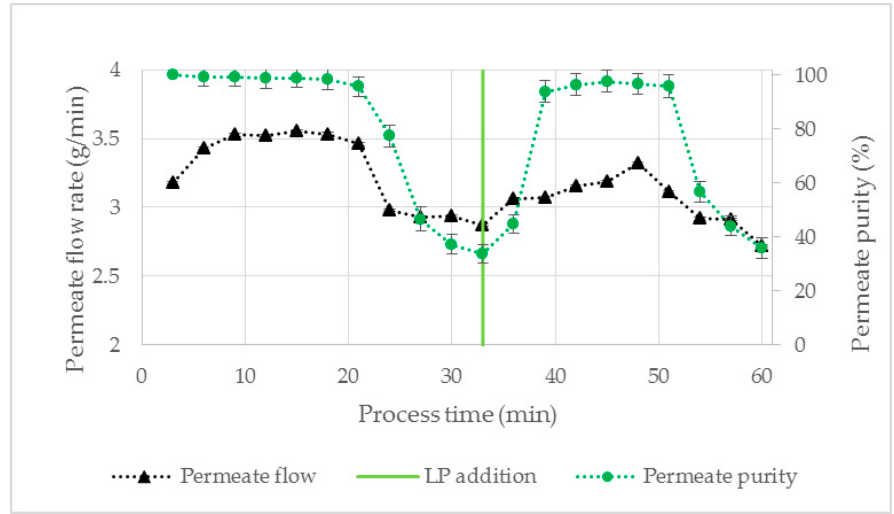
Figure 9. Effect of LP addition (50 mL) on permeate purity and flow rate. ATPS1, V = 150 Figure 9. E ff ect of LP addition (50 mL) on permeate purity and flow rate. ATPS1, V = 150 mL, mL, TMP = 10 mbar, Δ P = 30 mbar, Q = 16.7 mL/min. LP: light phase. TMP = 10 mbar, ∆ P = 30 mbar, Q = 16.7 mL / min. LP: light phase.